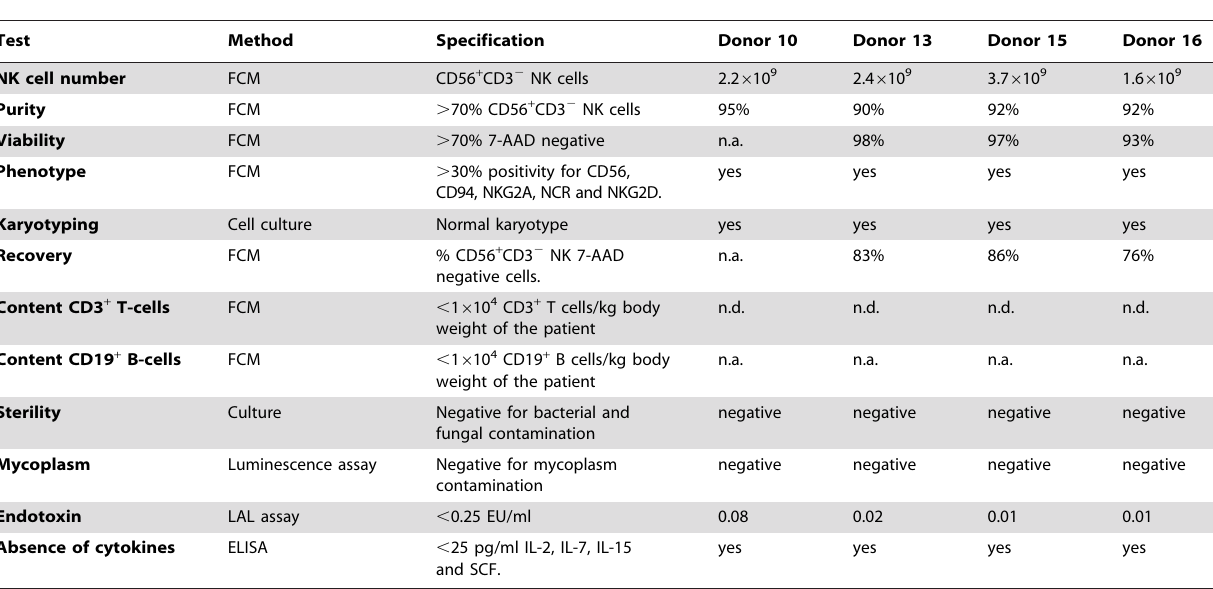
Table 4. Product release testing criteria and results of the final NK cell